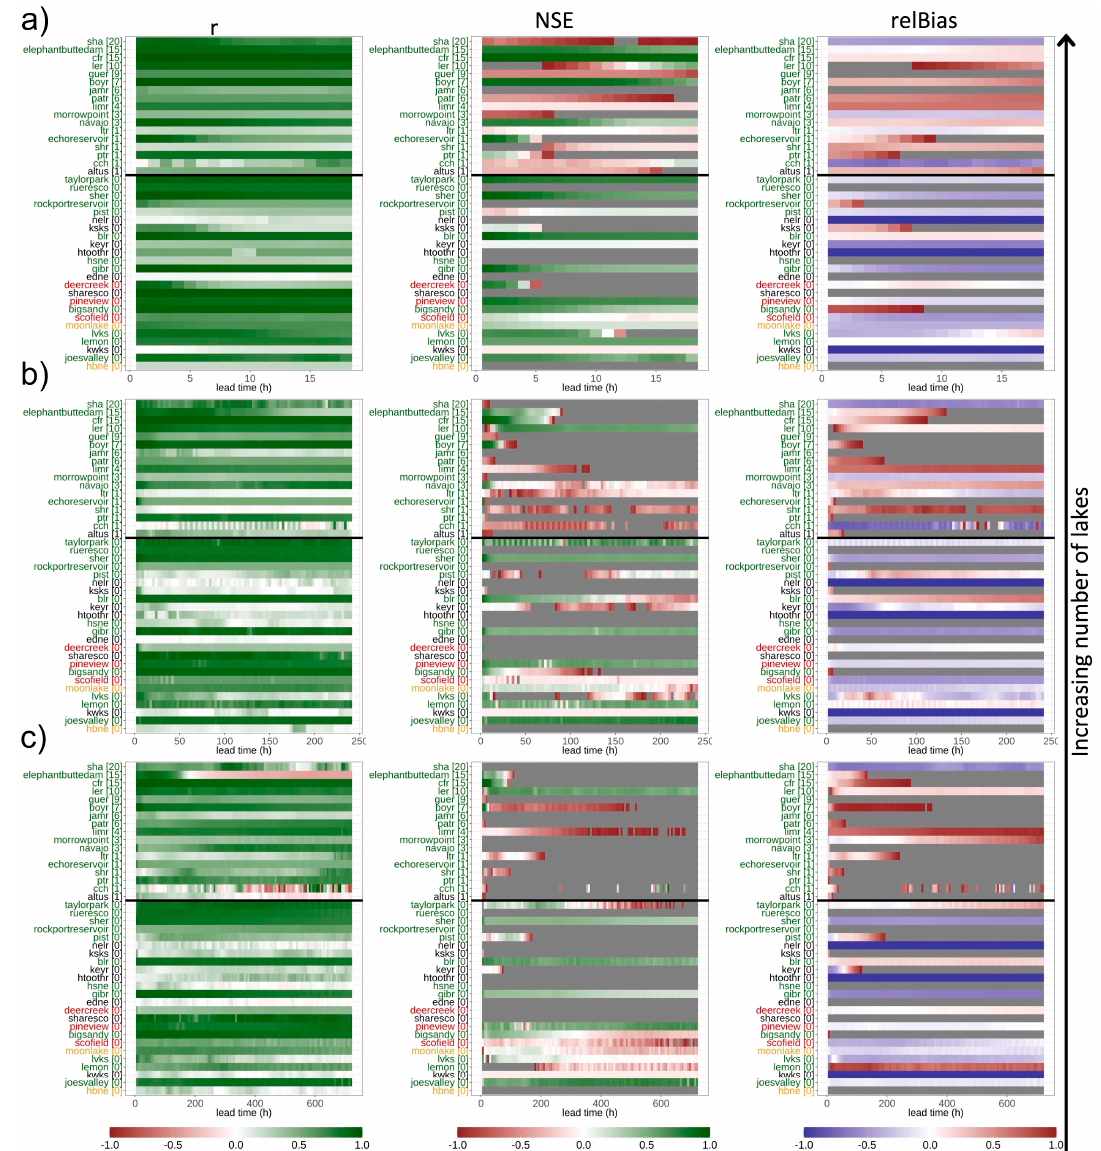
Figure 3. Performance of NWM reservoir inflows across lead times for one year, where reservoirs in each subplot are ordered from bottom to top by the number of upstream lakes (counts are listed in parenthesis on the y -axis with reservoir name). The black bold line separates reservoirs with more than zero lakes upstreams to the ones with zero lakes upstream.Each column from left to right columns illustrate r , NSE, relBias , where the metric is scaled by color density and grey is out of valid range ( relBias > +1 or relBias < − 1 and NSE < − 1). For r and NSE , green values are higher performance and red is worse; and for relBias , blue is high-biased and red is low-biased. The subplot rows are forecast cycles: short ( a ), medium ( b ), long ( c ).